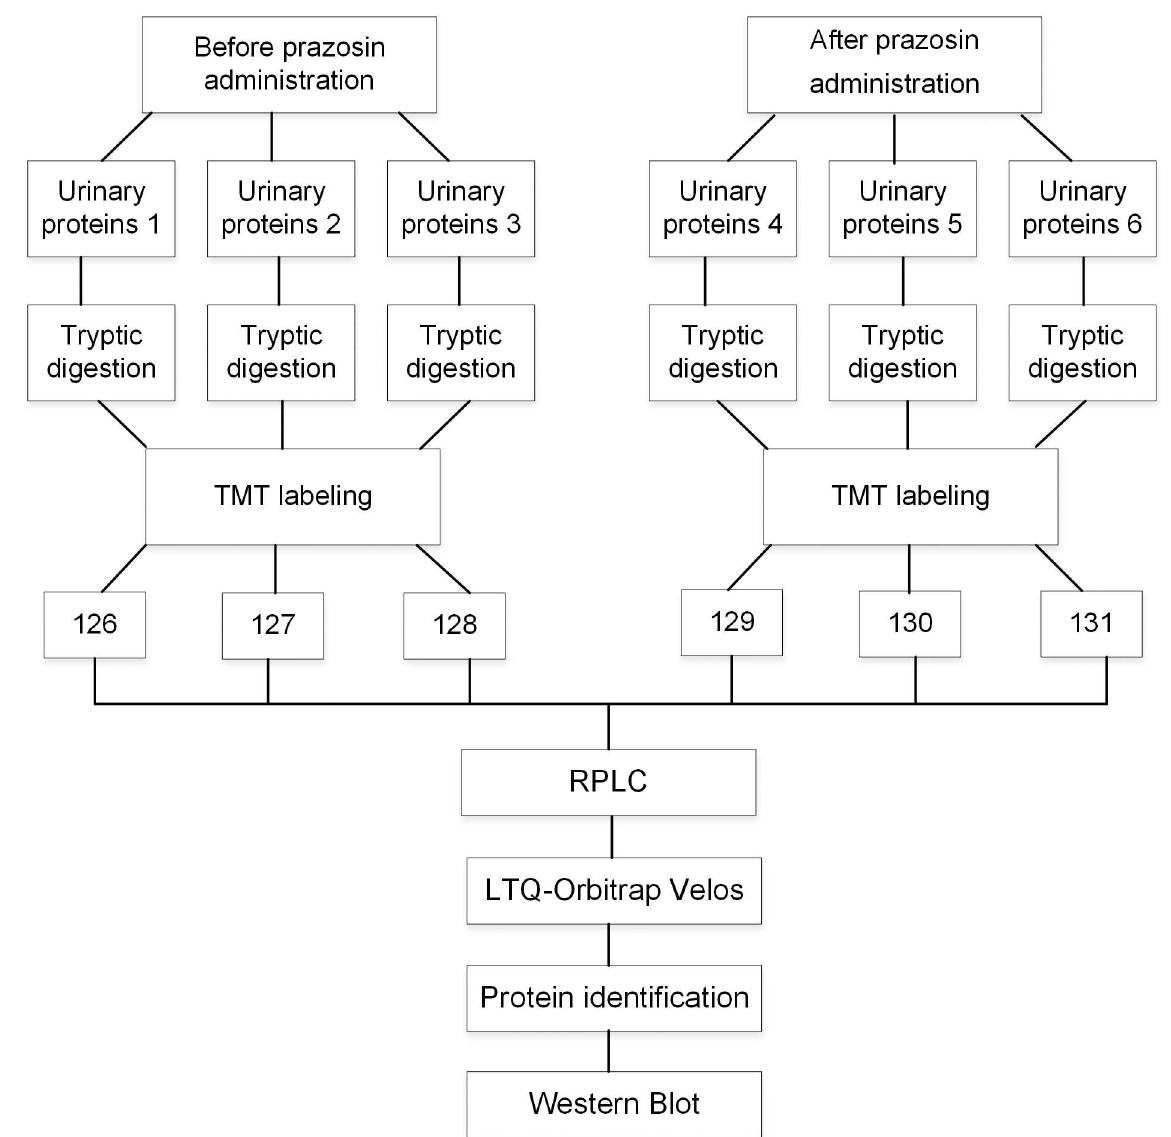
Fig 2. Workflow of the proteomic analysis. Urine samples were obtained before and after seven days prazosin administration. The labeledpeptides were analyzedusing 2DLC-MS/MS for identification and quantification.